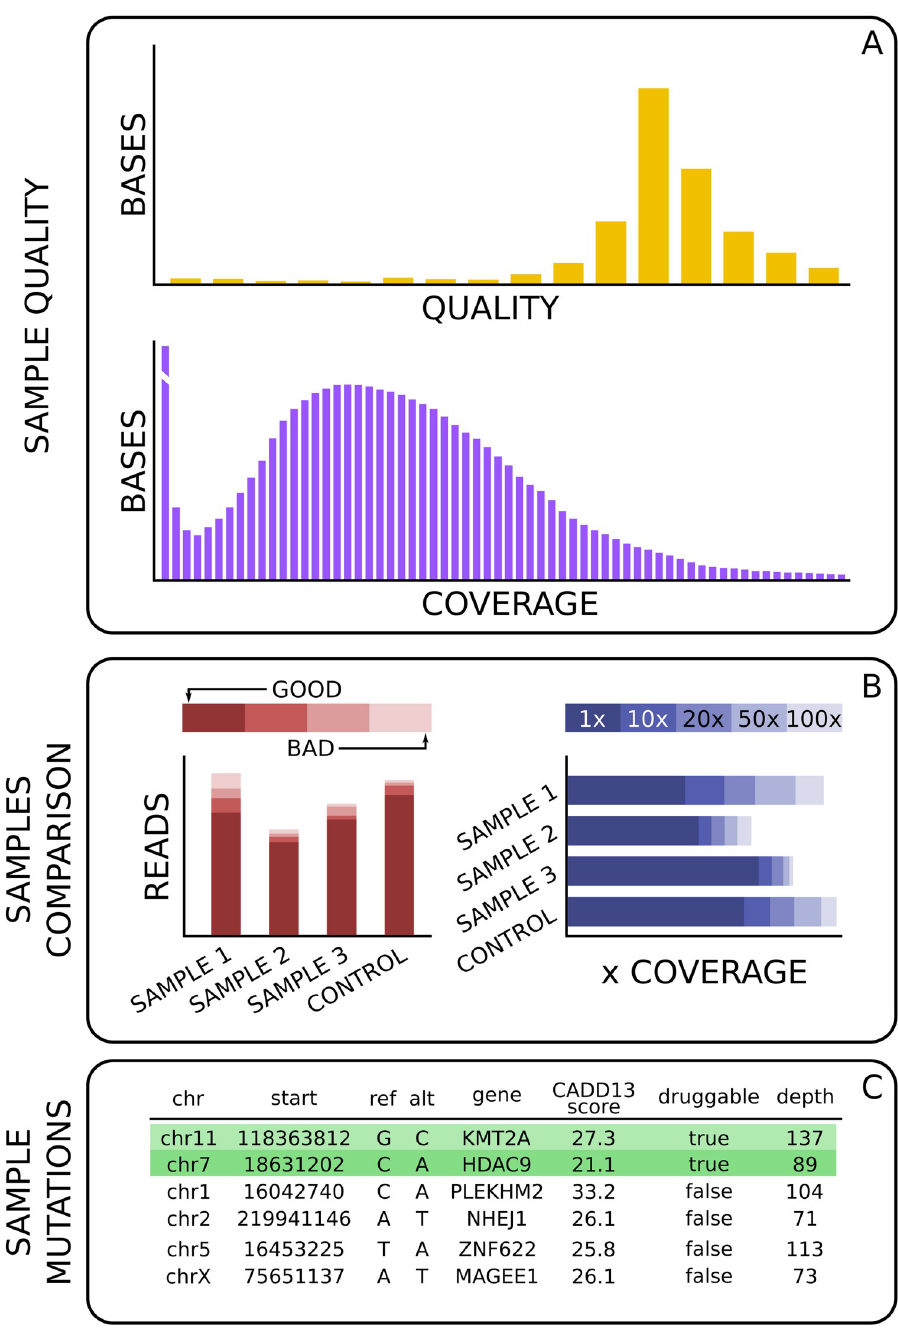
Fig 2. Representation of the output in a report automatically generated by HaTSPiL. (A) Two of the plots showing the quality of a single sequencing. The values are obtained using Picard software (https://broadinstitute.github.io/ picard/). (B) Two comparisons between samples and relative control. This representation is used with a scalable amount of samples, from a single sample to all the samples available for a whole project. A control sample is always added, if available, in order to provide a minimal comparison against another sequencing. (C) A portion of the table containing the mutations found highly damaging by the variant calling. The mutated genes that are known to be a target of a drug are